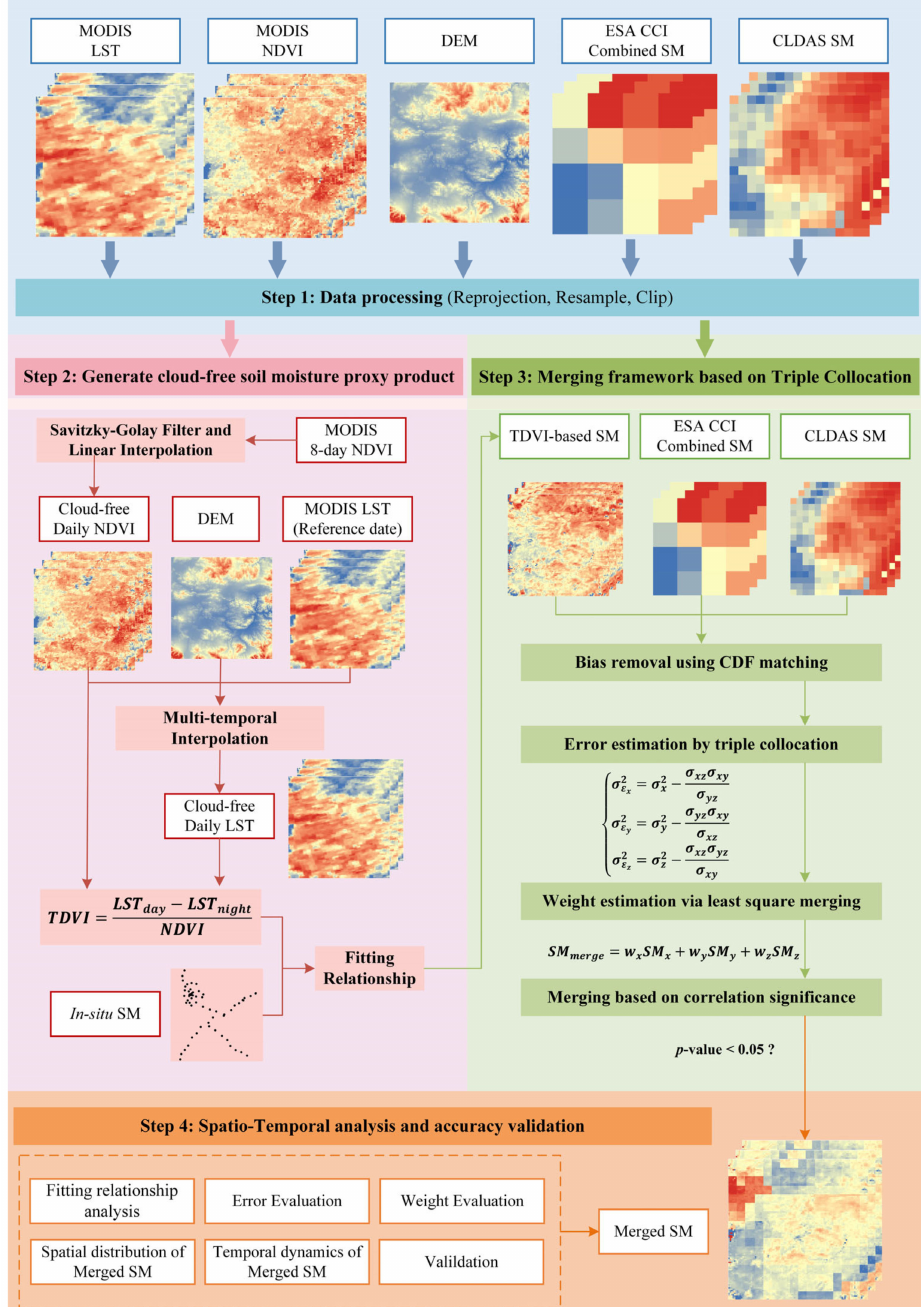
Figure 2. Schematic diagram of our proposed merging method to obtain 1 km spatial resolution daily SM by spatiotemporal interpolation and triple